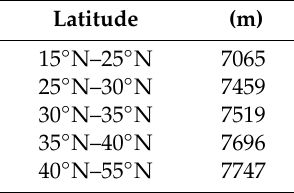
Table 1. The fitted tropospheric scale height for di ff erent latitude groups.